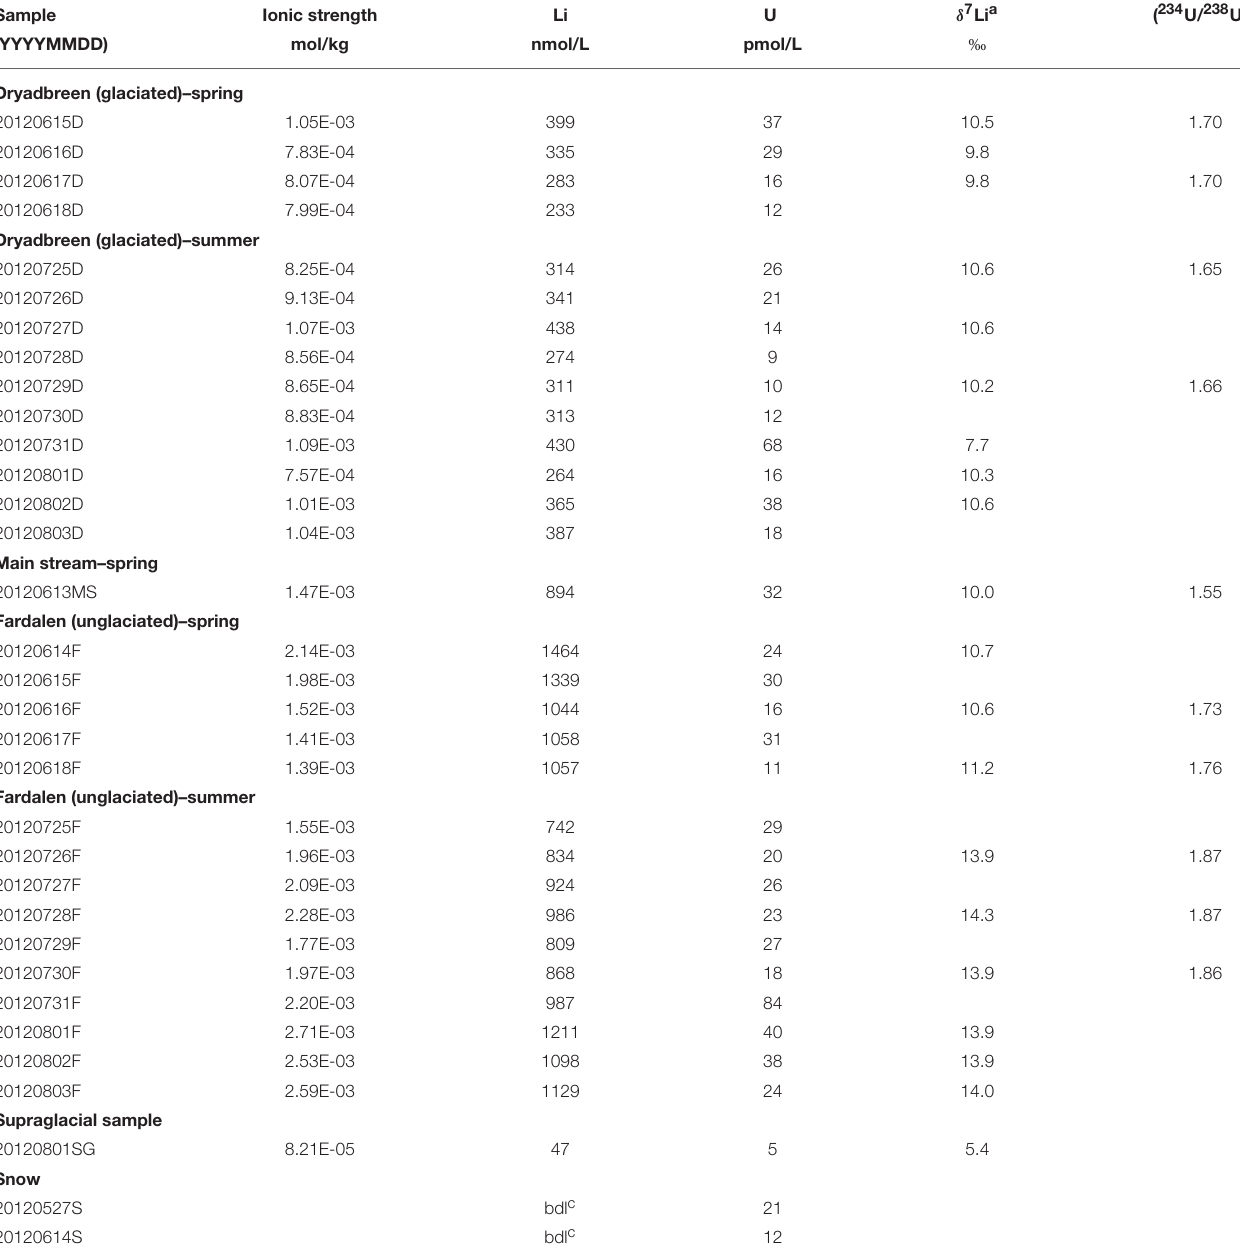
TABLE 2 | Ionic strength and Li and U concentration and isotopic data.